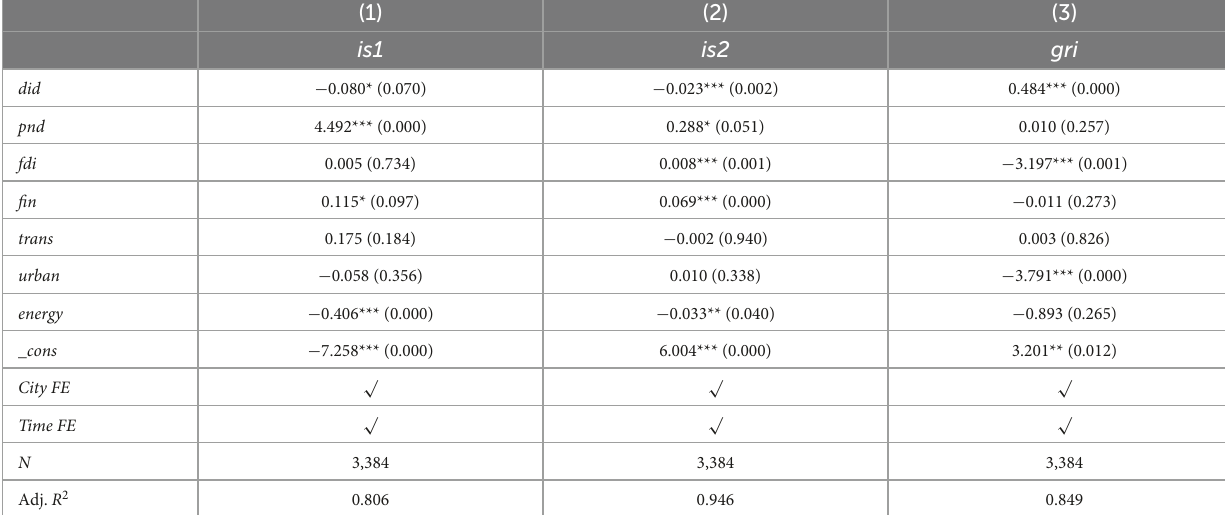
TABLE 4 Mechanism